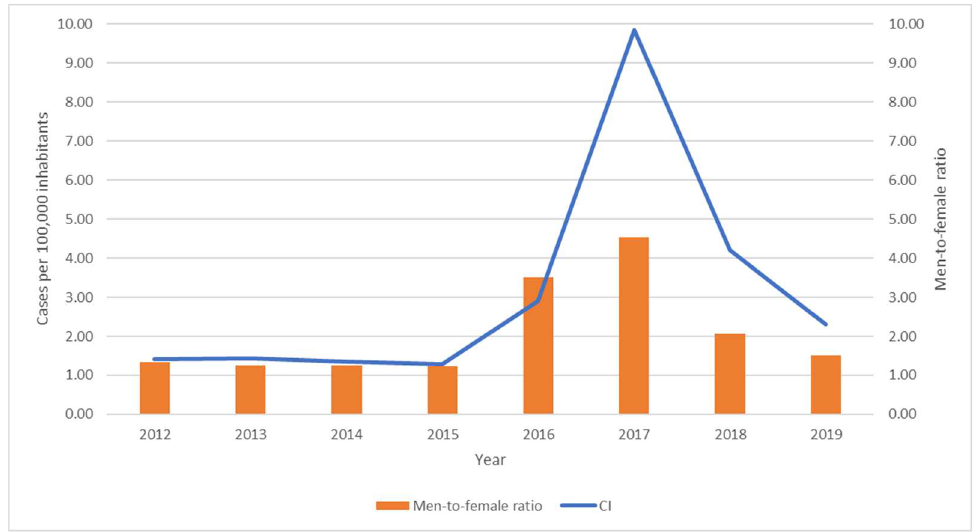
Figure 3. Cumulative incidence (CI) and male-to-female ratio, 2012–2019.